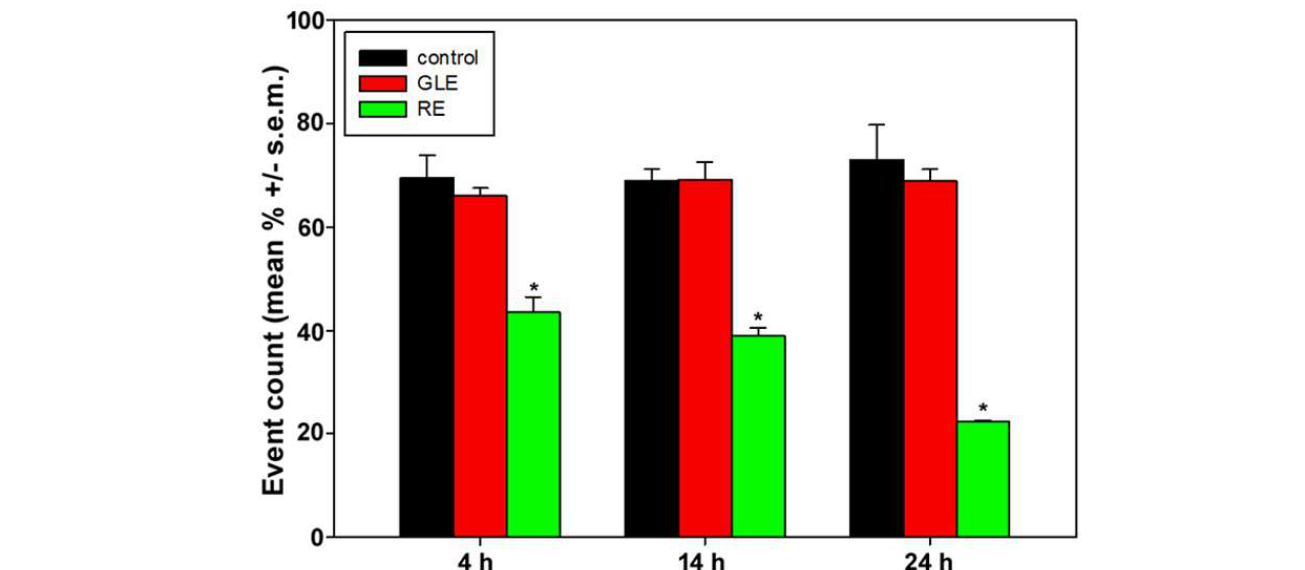
Figure 6. (Upper panel) flow cytometric assays for MMP in HepG2 cells cultured for 4, 14, and 24 in control conditions or exposed to 1 μM valinomycin (positive control) or the IC 50 of either GLE or RE. The plots show the results of representative experiments, and the percentages in each frame, indicated as the mean ± s.e.m. of three independent assays, are referred to the intense red-emitting cells with intact MMP in the gated area. (Lower image) bar graph summarizing the data for control and treated cells with intact MMP obtained from triplicate experiments. * normality test vs. control passed.